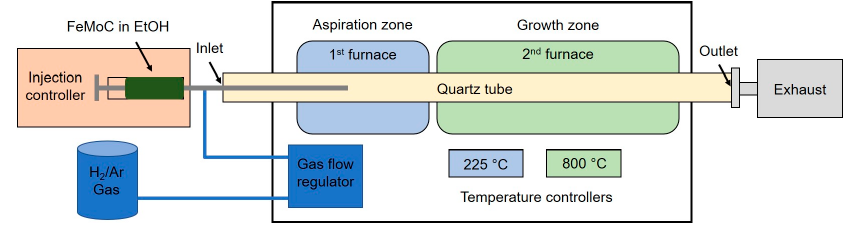
Figure 1. Schematic of the direct liquid injection chemical vapor deposition furnace.